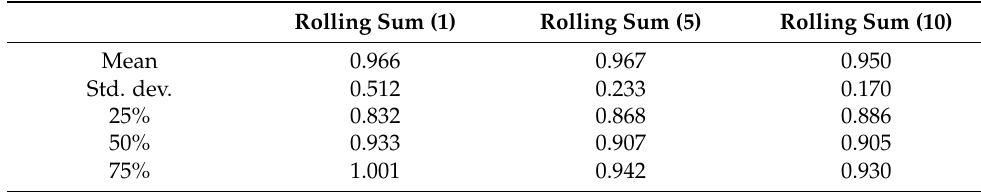
Table 5. Aggregated performance comparison of the new protocol based on the C25 clustering against the baseline